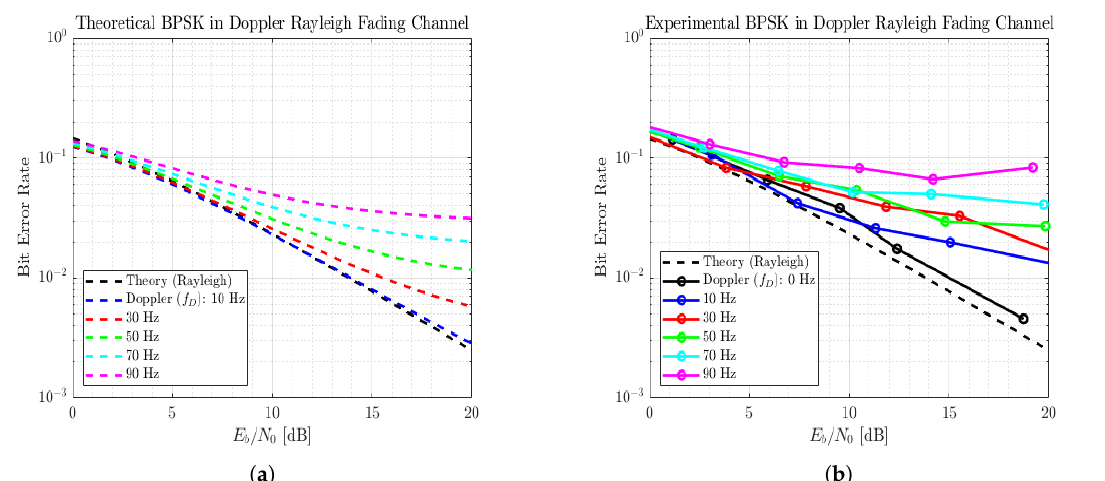
Figure 12. Doppler impact on channel estimation for: ( a ) the theory and ( b ) experimental measurements.